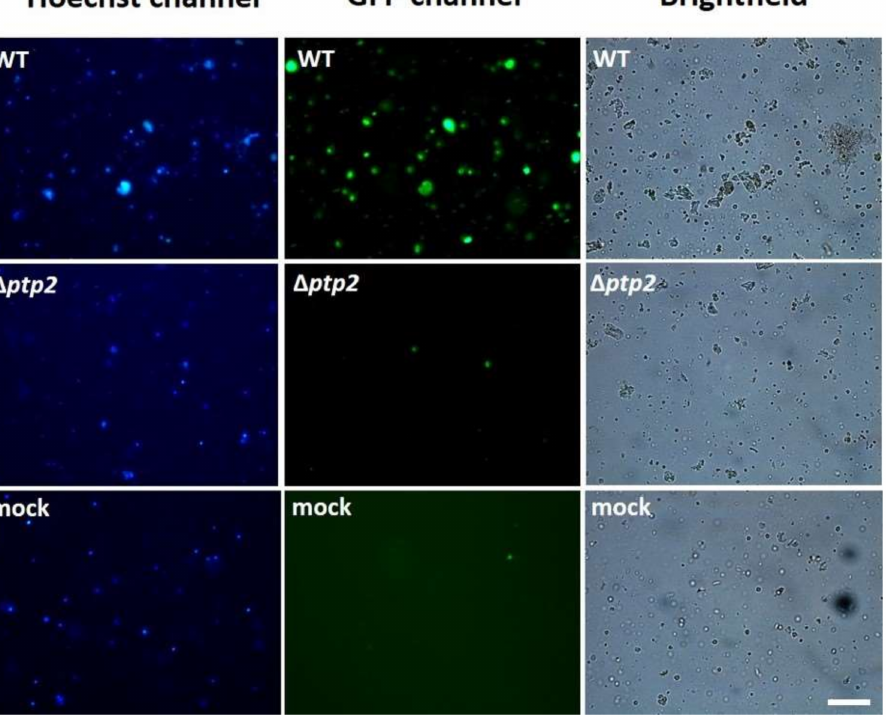
Figure 3. Fluorescence microscopy analysis of cells in S. exigua hemocytes at 48 h post transfection. Cells were stained with Hoechst (left panel) and Annexin V-EGFP (middle panel). Cells were obtained from larvae infected with wild-type (WT) Spodoptera exigua multiple nucleopolyhedrovirus (SeMNPV), ∆ ptp2 SeMNPV or no virus (mock), scale bar = 200 µ